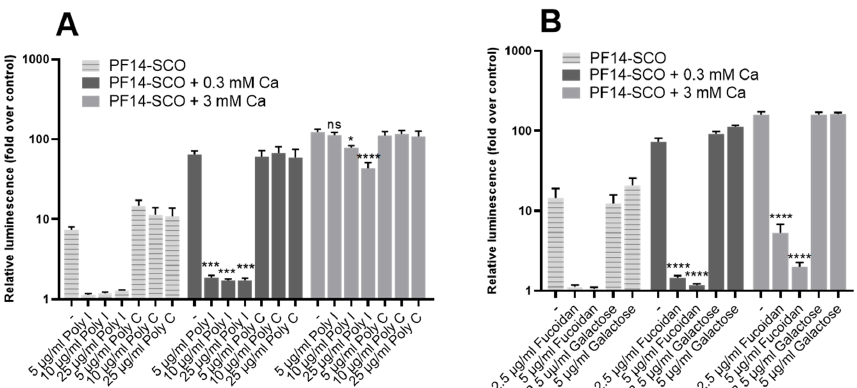
Figure 8. The effect of inhibitors of class A scavenger receptors, SR-As, on biological activity of PF14-SCO nanoparticles. HeLa pLuc 705 cells were incubated with solutions containing SR-A inhibitors Poly I ( A ) or fucoidan ( B ) that were added to growth medium at different concentrations. As a negative control, chemicals with analogous structure to the inhibitors, Poly C and galactose, respectively, were used. After 1 h incubation, nanoparticles of 100 nM SCO, 500 nM PF14 and 0.3 or 3 mM Ca 2+ were added and luminescence was measured after 24 h. Each dataset represents mean + SEM of 3 independent experiments. Data was analyzed by one-way ANOVA with Tukey’s test. Asterisks indicate statistically significant difference with the same nanoparticle without inhibitor or its analogue added, * p -value < 0.05, *** p -value < 0.0005, **** p -value < 0.0001, ns—not